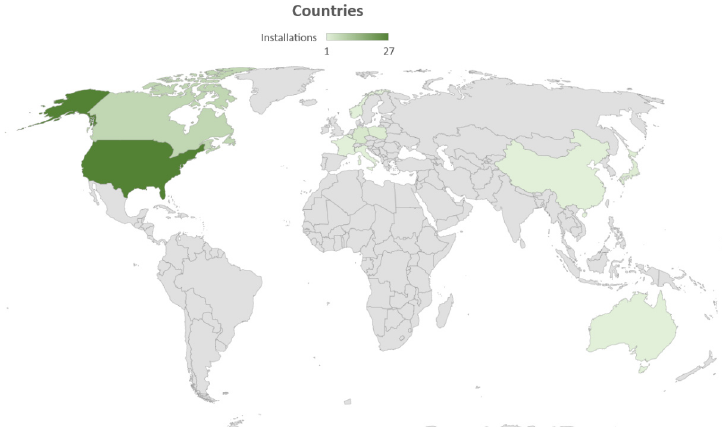
Figure 1. World map from Table 1 of active CEA installations by country.